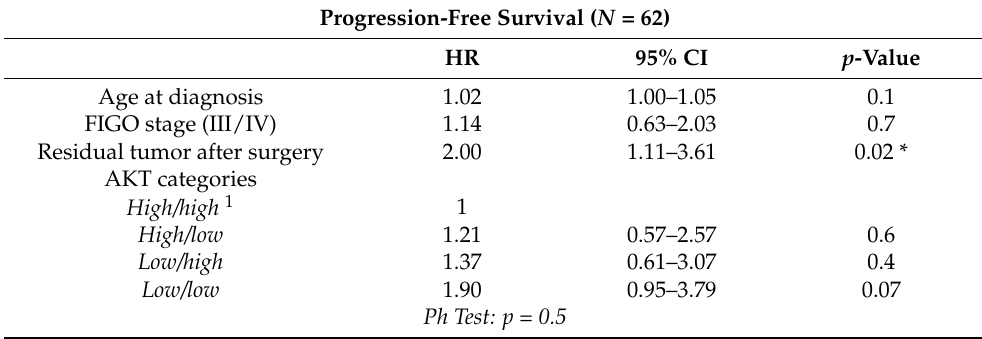
Table A2. Prognostic factors for PFS identified by multivariate Cox regression